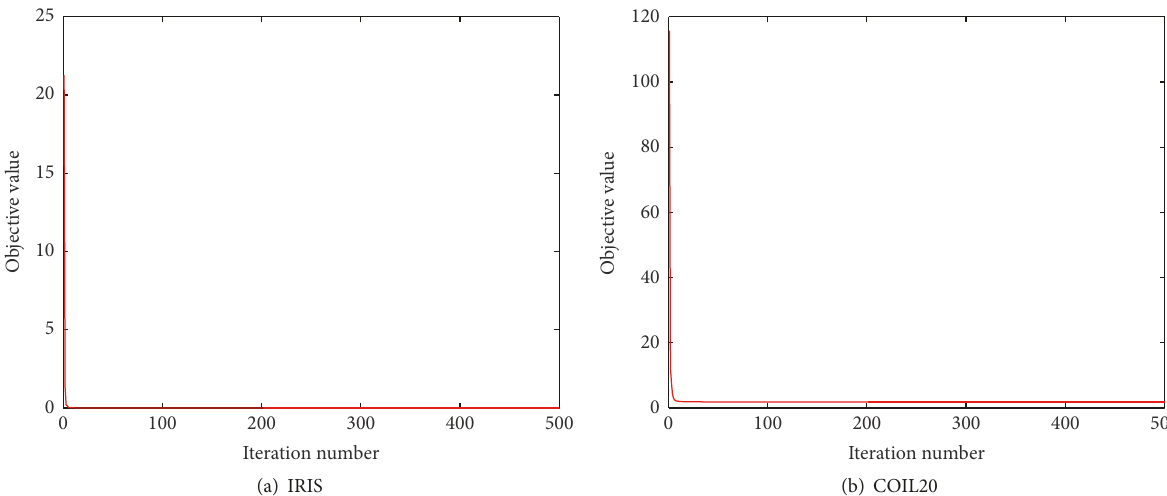
Figure 4: Iteration number versus objective value (100 :1 scale) for GSNMF when 𝜆 = 5 on IRIS and COIL20 data